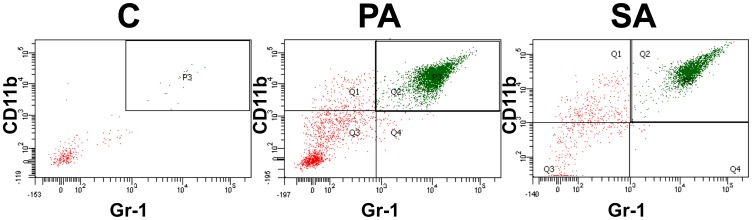
Neutrophils relative proportion determination by flow cytometry study.Example of representative gating obtained by flow cytometry of BAL collected from non-infected mice (PBS treatment: control, C) or pneumonia mouse model 24 hours after tracheal instillation of Pseudomonas aeruginosa, PA; or Staphylococcus aureus, SA. For this experiment, neutrophils were considered as Gr-1pos CD11bpos cells.